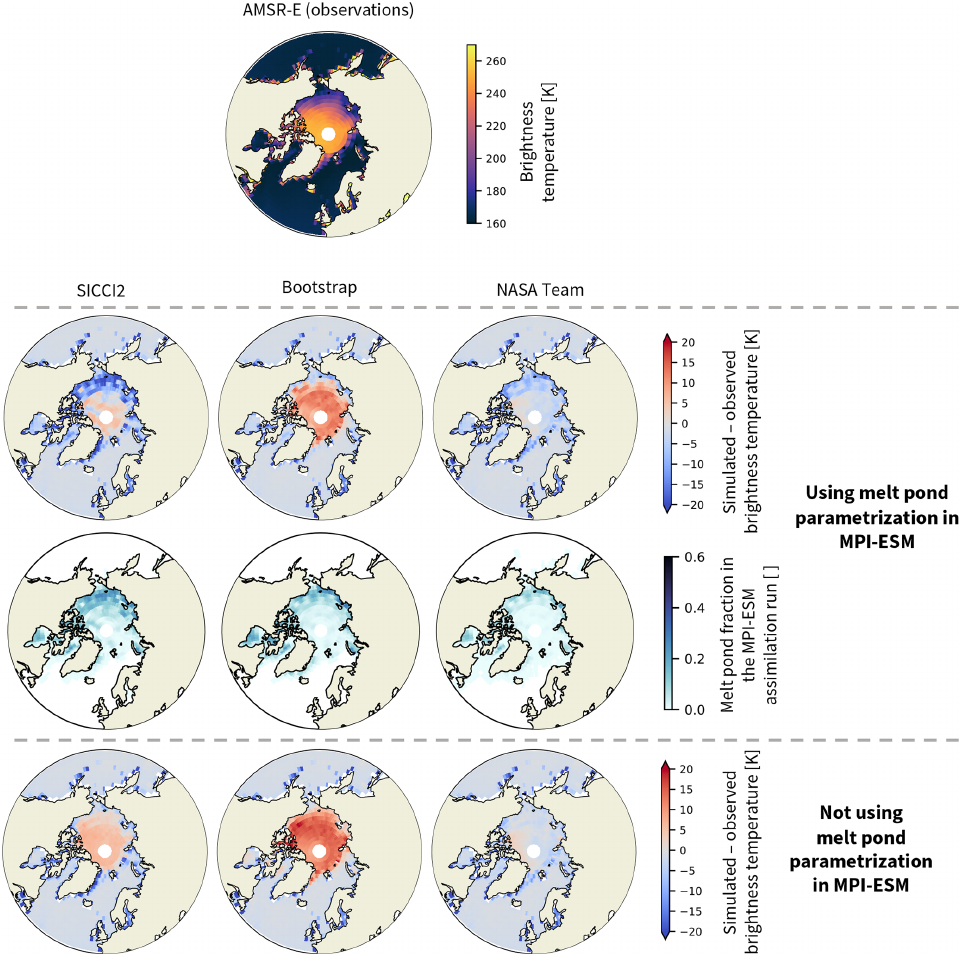
Figure 9. Experiment to compare brightness temperatures in summer (July–August–September) simulated based on assimilation runs as- similated with different sea ice concentration products (SICCI2, Bootstrap, NASA Team) to brightness temperatures measured by AMSR-E. Observations by AMSR-E are shown in the first row. The difference between simulated and observed brightness temperatures if melt ponds are taken into account (second row) and if they are set to zero (fourth row) is shown. In the third row, the melt pond fraction simulated by MPI-ESM is